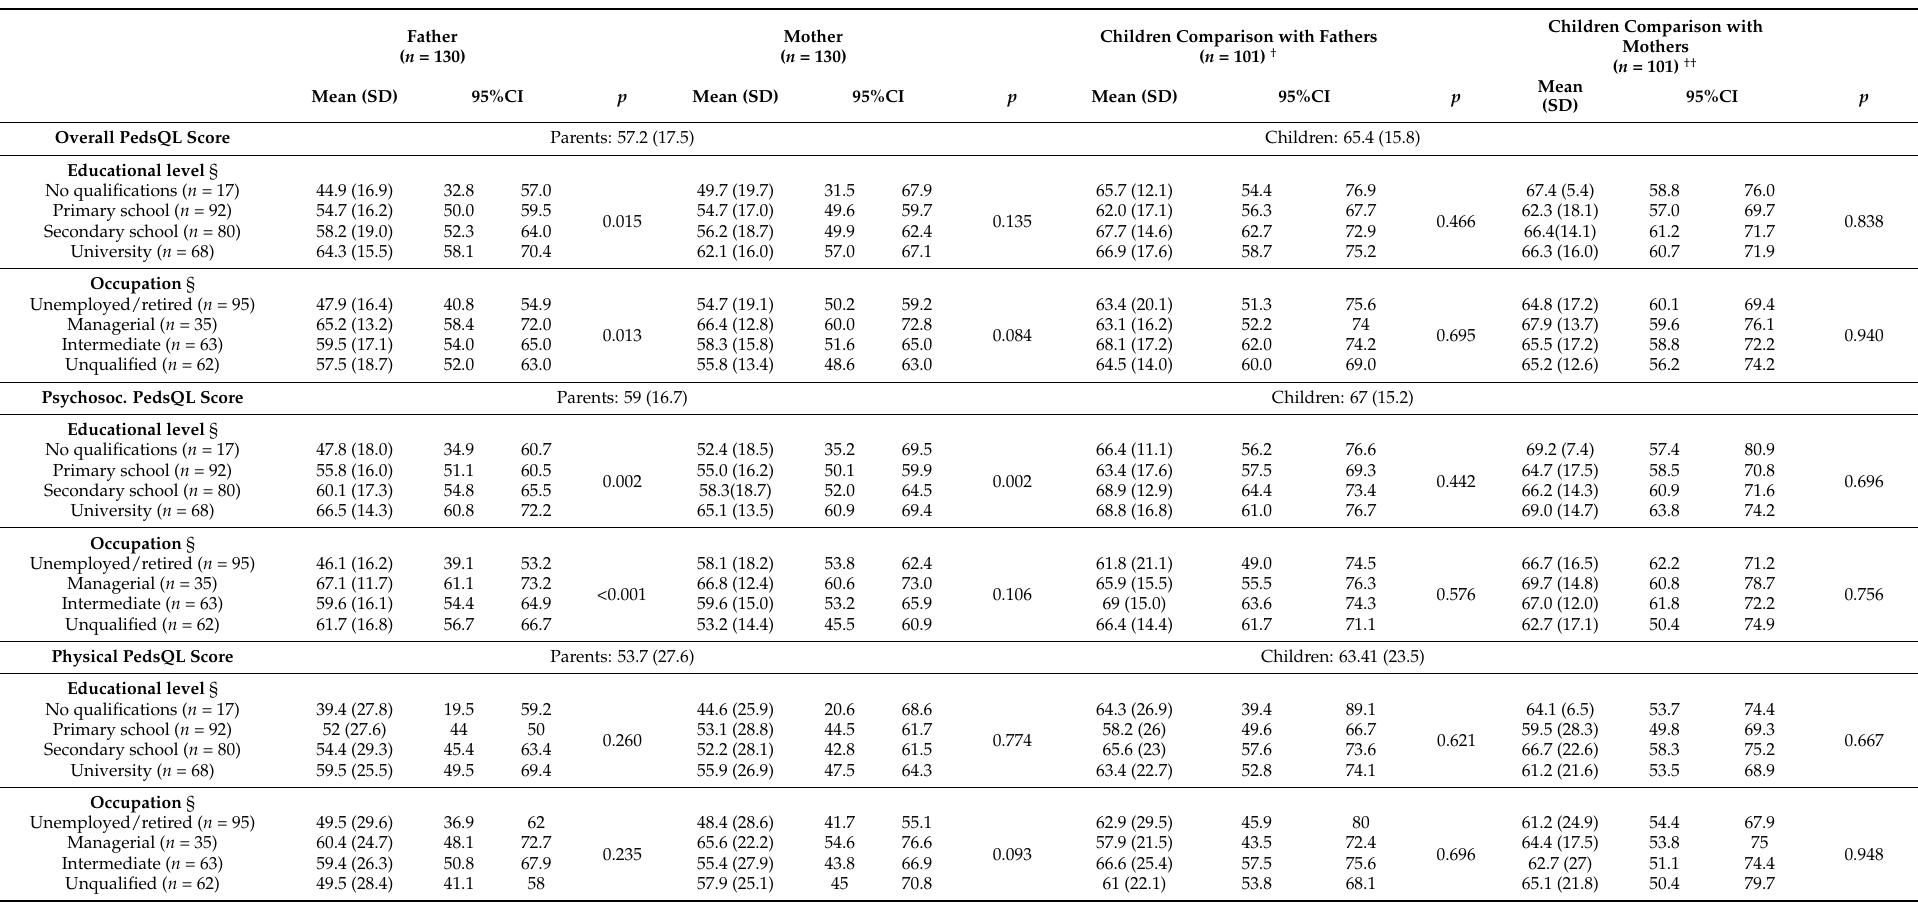
Table 2. PEDSQL and sociodemographic